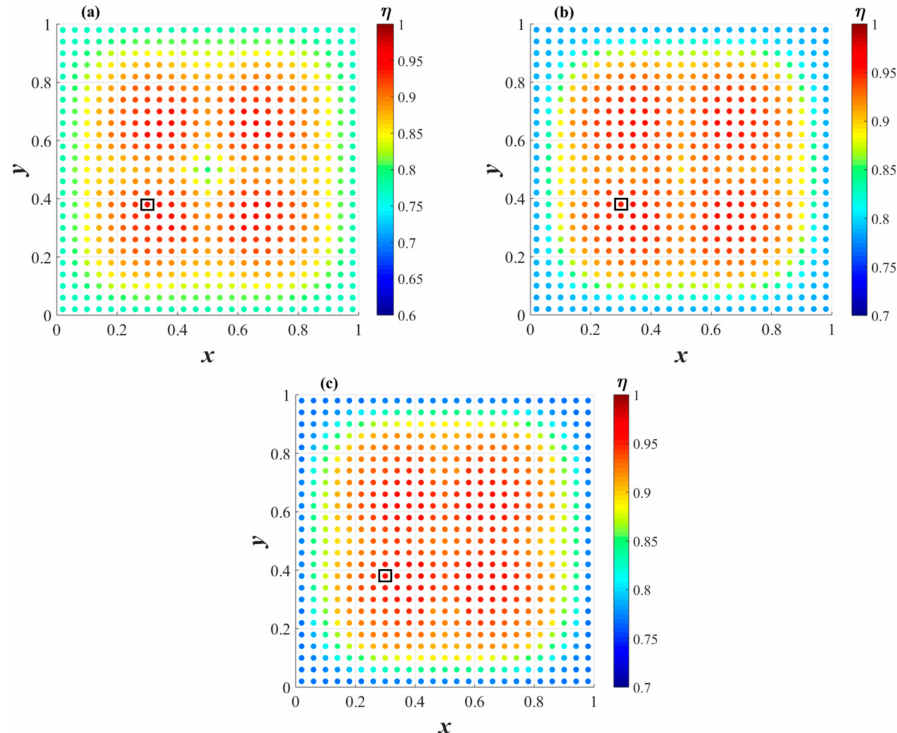
Figure 19. The energy dissipation ratios of the five NESs at different positions under different